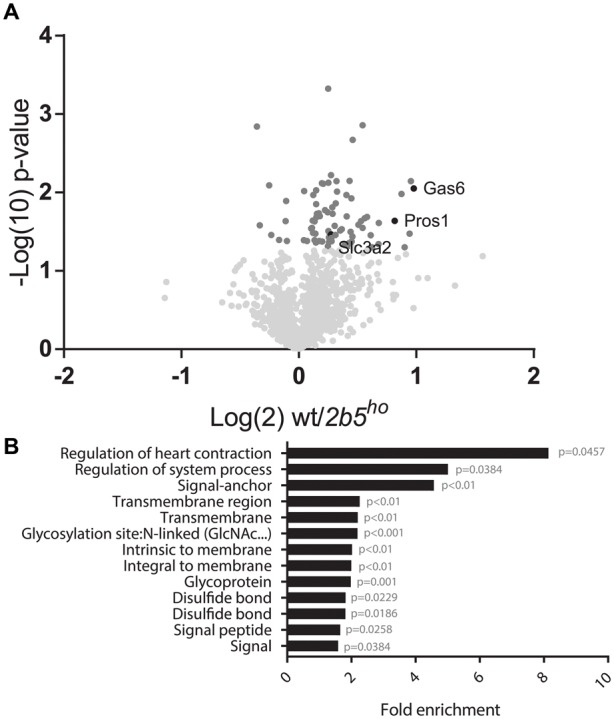
Volcano plot of all 1240 proteins from the proteomic screen and DAVID analysis of the 80 proteins regulated by eIF2B𝜀Arg191His identifies a difference in proteins that migrate through the secretory pathway. (A) In the volcano plot the proteins in darker gray have a p-value < 0.05 and are considered significantly differently synthesized between wt and 2b5ho astrocyte cultures. The p-values are plotted as Log(10) and p < 0.05 corresponds to -Log10 > 1.12. The fold change between wt and 2b5ho is plotted as Log(2) and a fold change of >2 corresponds to Log(2) > 1. 80 proteins are significantly different between wt and 2b5ho astrocytes of which 72 are increased and 8 are decreased in 2b5ho astrocytes. The proteins SLC3A2, PROS1, and GAS6 are highlighted in black. (B) The figure shows the overrepresentation analysis (p-value < 0.05) between the significantly different proteins with the proteins found in the proteome as a background. The pathway analysis reveals an overrepresentation of proteins with a signal peptide, transmembrane domain, N-linked glycosylation site(s) and/or disulfide bond(s). These terms together pinpoint targeting of proteins to the secretory pathway, some of which are post-translationally modified, as being affected by this mutation.